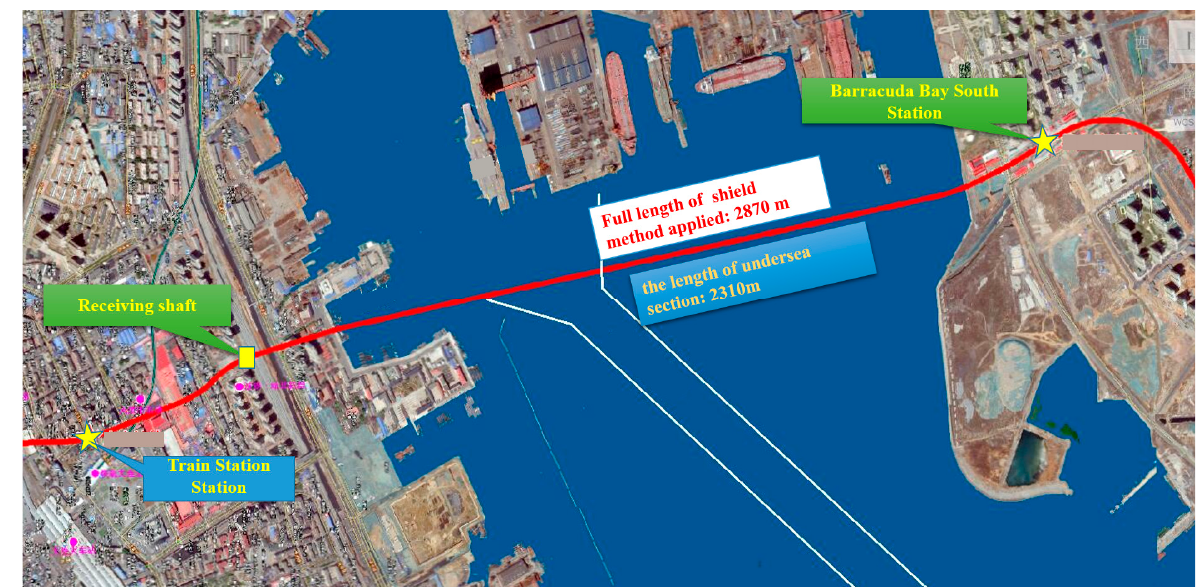
Figure 6. The layout of the undersea metro tunnel in Dalian, China.